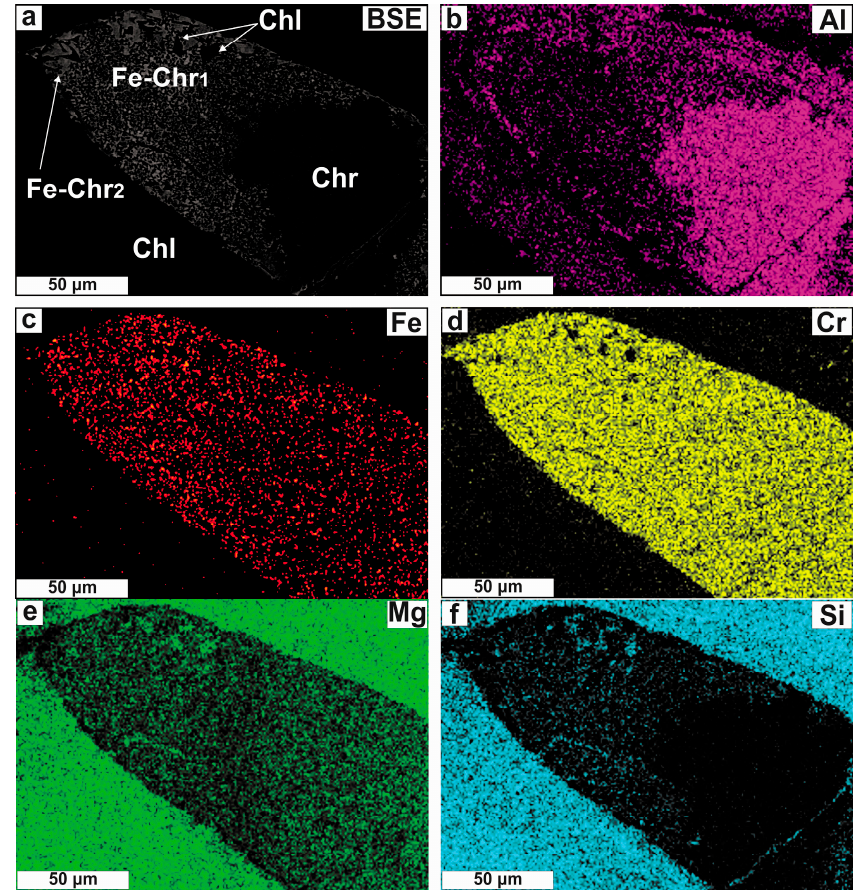
Figure 12. Single-element (EDS) X-ray maps on part of a Cr-spinel grain that displays oriented lamellae intergrowth texture.